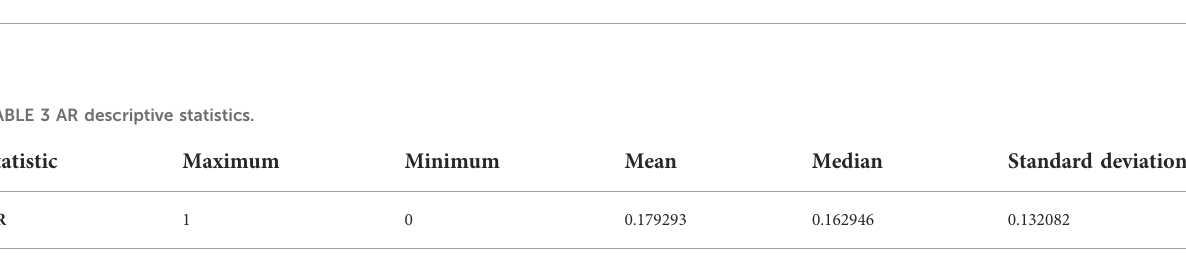
FIGURE 3 Distribution of Time. The vertical coordinate is the number of rumors, and the horizontal coordinate is the different time distribution (A) : 1 day; (B) 1 week; (C) observation period).